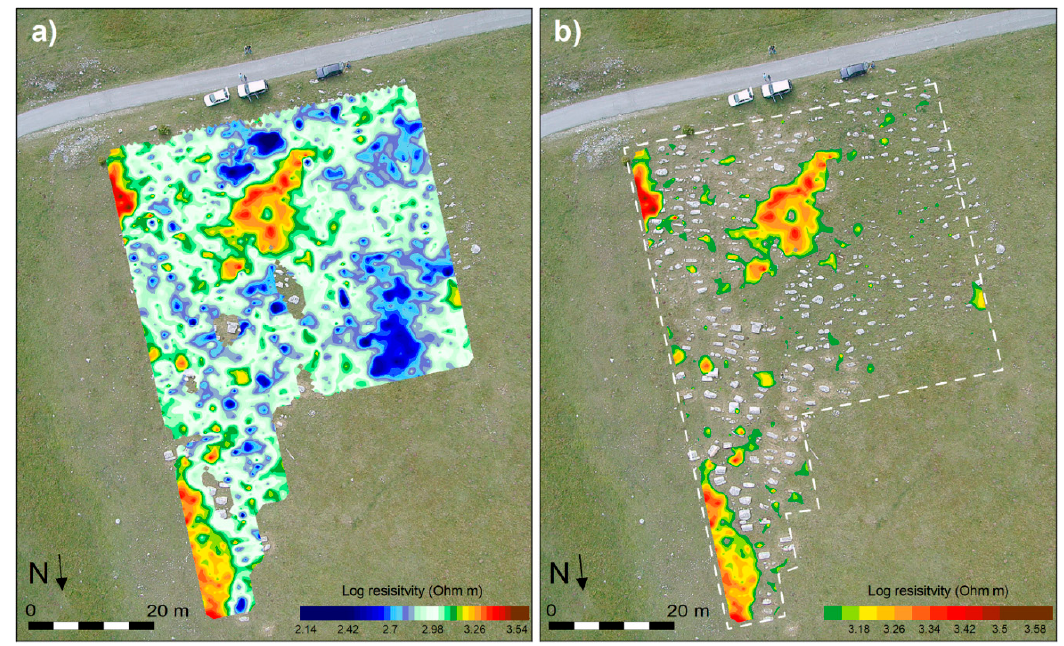
Figure 23. Ste ć ci of Žugi ć a: electrical resistivity map relative to 1 m in depth using two different colour scales according to which lower resistivity values are visualized through the shades of blue ( a ) or are made transparent ( b ).